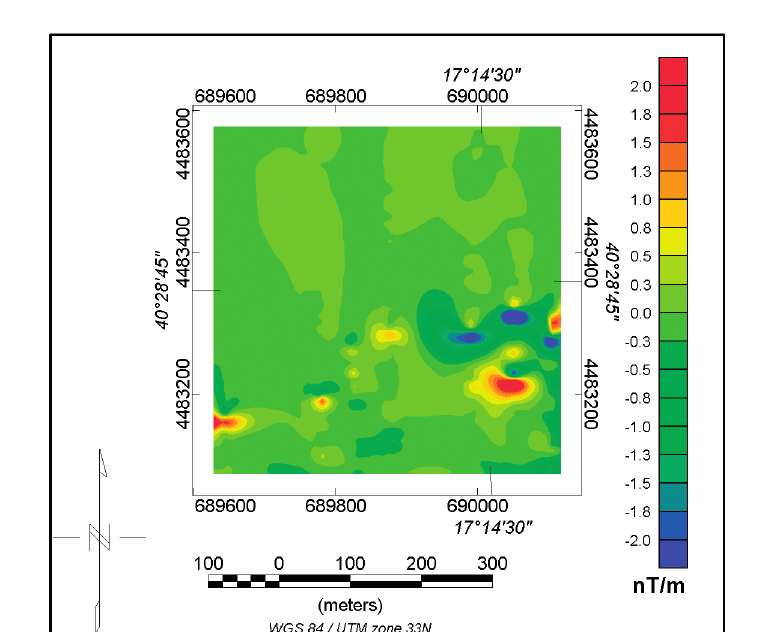
Fig. 3. Magnetic gradient: the east-west component.